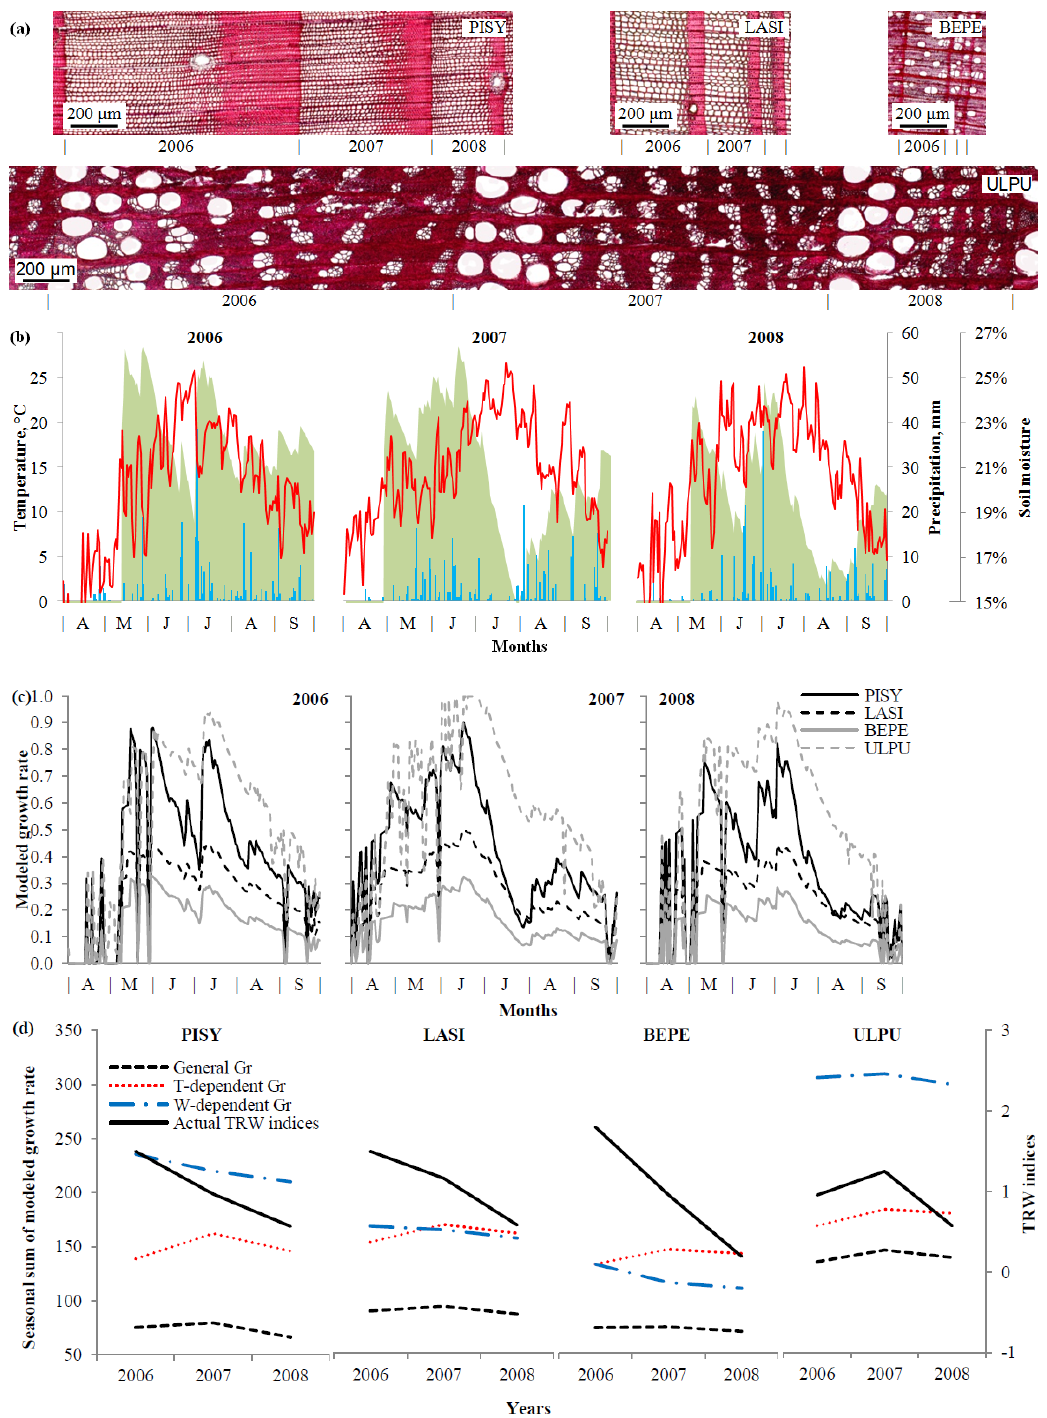
Figure 6. Growth patterns of the four considered species and external conditions during 2006–2008, namely: ( a ) Examples of tree rings’ cell structure microphotographs. ( b ) Daily dynamics of the temperature (lines) and precipitation (bars) during April–September, and the modeled soil moisture (shaded areas), averaged for all of the considered species starting from the modeled onset of radial growth. ( c ) The modeled daily series of the general growth rate (in a unit share, i.e., a fraction of the maxima growth rate) for each species. ( d ) The total seasonal sum of the modeled growth rates (Gr; in a unit share): general growth rate (black dashed lines), temperature-dependent partial growth rate (dotted lines), wetness-dependent partial growth rate (dot dash lines), and actual TRW indices (solid lines).